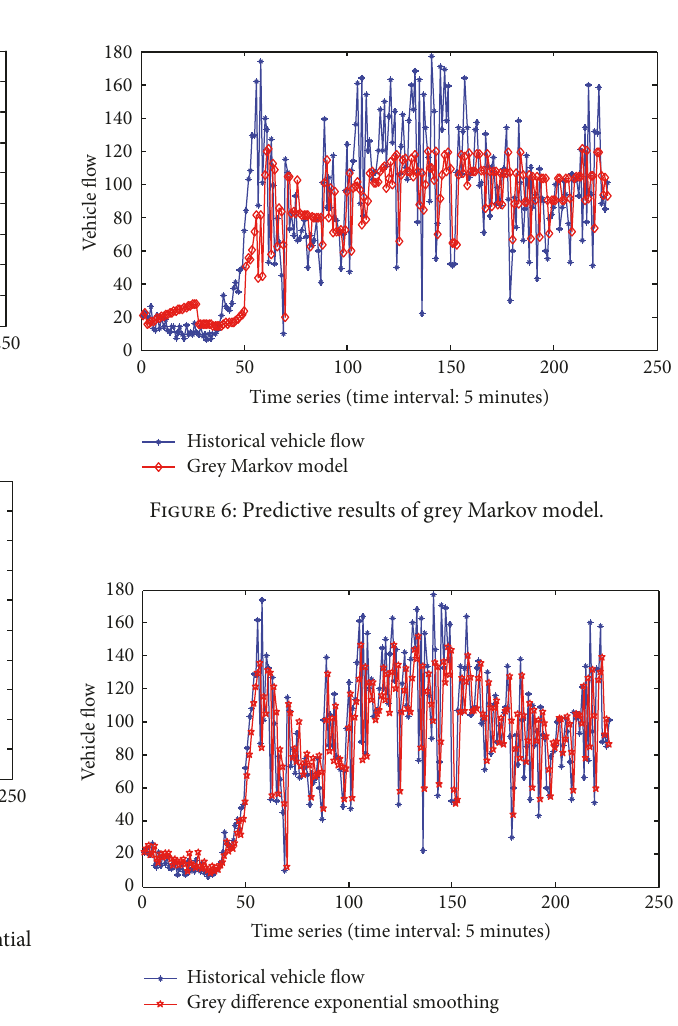
Figure 7: Predictive results of grey difference exponential smooth- ing